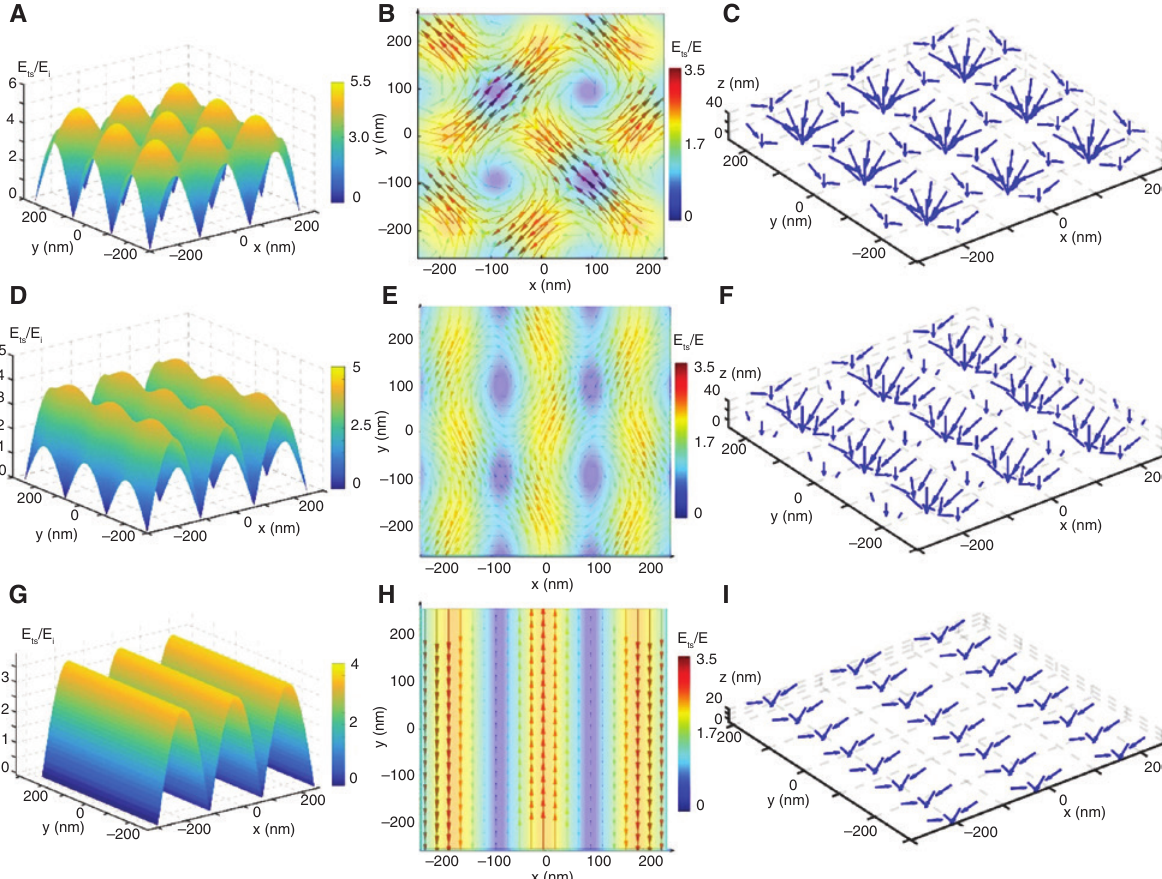
Figure 3: Electric field amplitude ratio, field vector distribution on the intensity background, and 3D distribution of optical gradient force acting on the colloidal silver NPs (radius a = 10 nm) in the orthogonal LSEW fields with different optical power intensity tuning factors. (A–C) γ = 1, (D–F) γ = 2 2, and (G–I) γ =